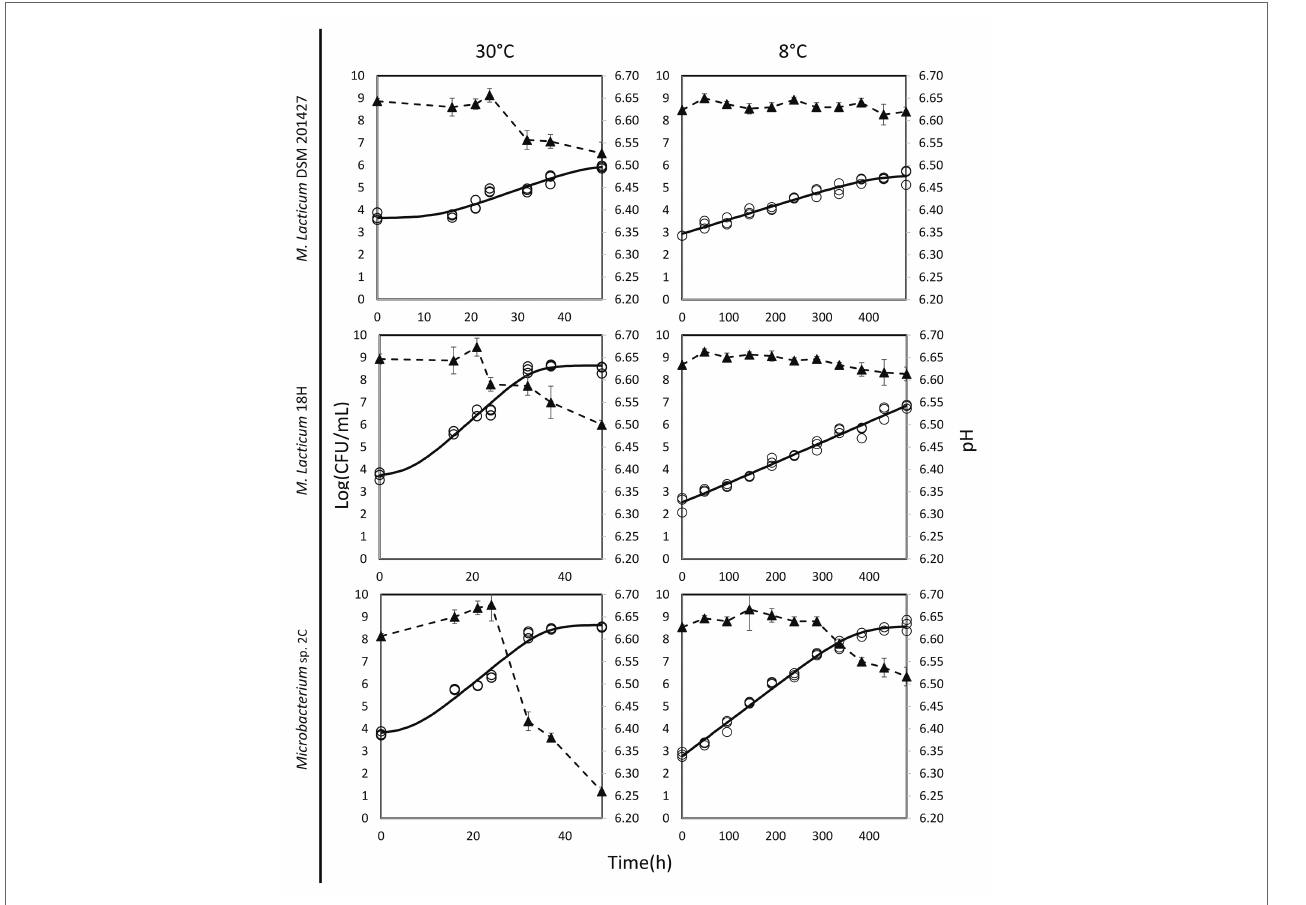
FIGURE 1 | Dynamics of growth and acidification in milk of M. lacticum DSM 20427, M. lacticum 18H, Microbacterium sp. 2C at two different temperatures, 30 and 8 ° C. The growth results were based on triplicate measures ( ○ ). The continuous line (-) shows the growth curve resulting from the DMFIT (Baranyi and Roberts, 1994). The acidification curve ( ▲ , - -) is expressed as mean values from triplicate measures.